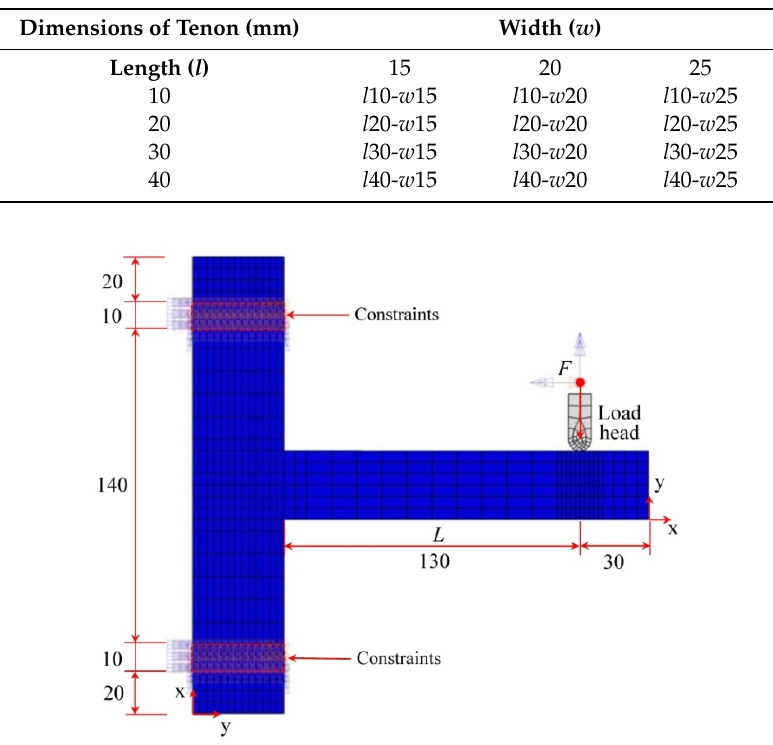
Figure 2. The finite element model (FEM) of T-shaped mortise-and-tenon joint specimen with load and constraint conditions.